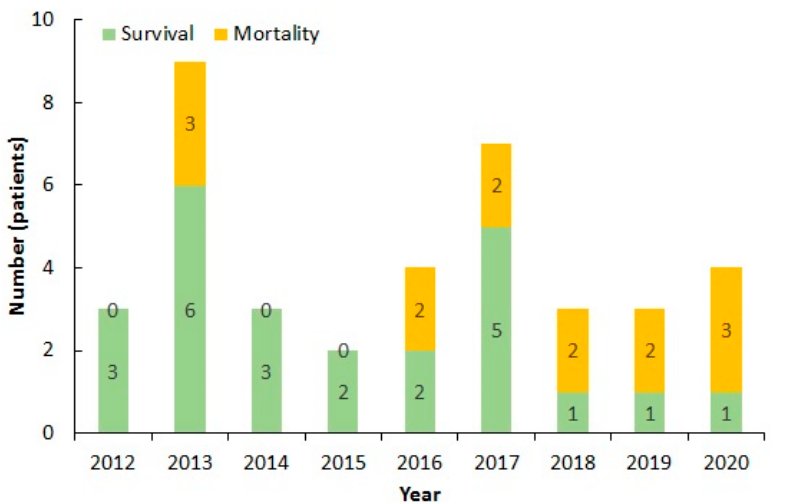
Figure 1. The associations between years distribution with survival and mortality of the 38 patients with Listeria monocytogenes bacteremia (P = 0.264). (Green: survival patient number; Yellow: mortality patient number) from 2012 to 2020.